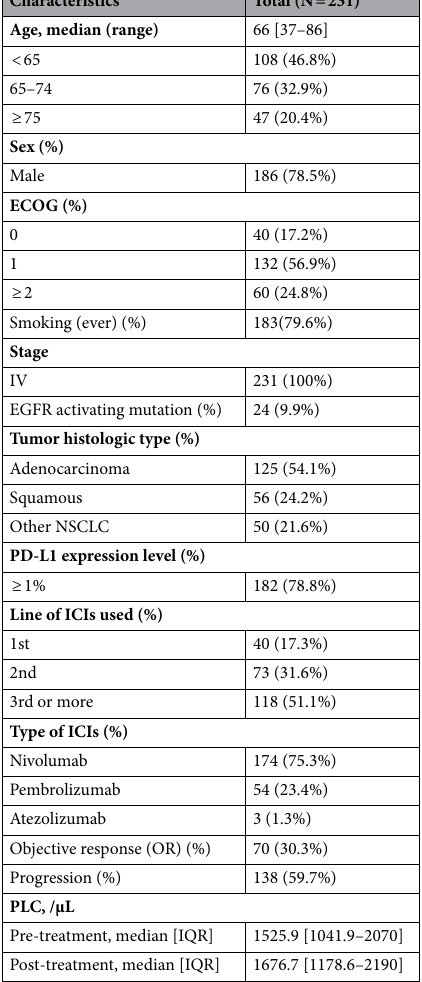
Table 1. Baseline characteristics of study patients. OR, partial response and complete response; PLC, peripheral lymphocyte